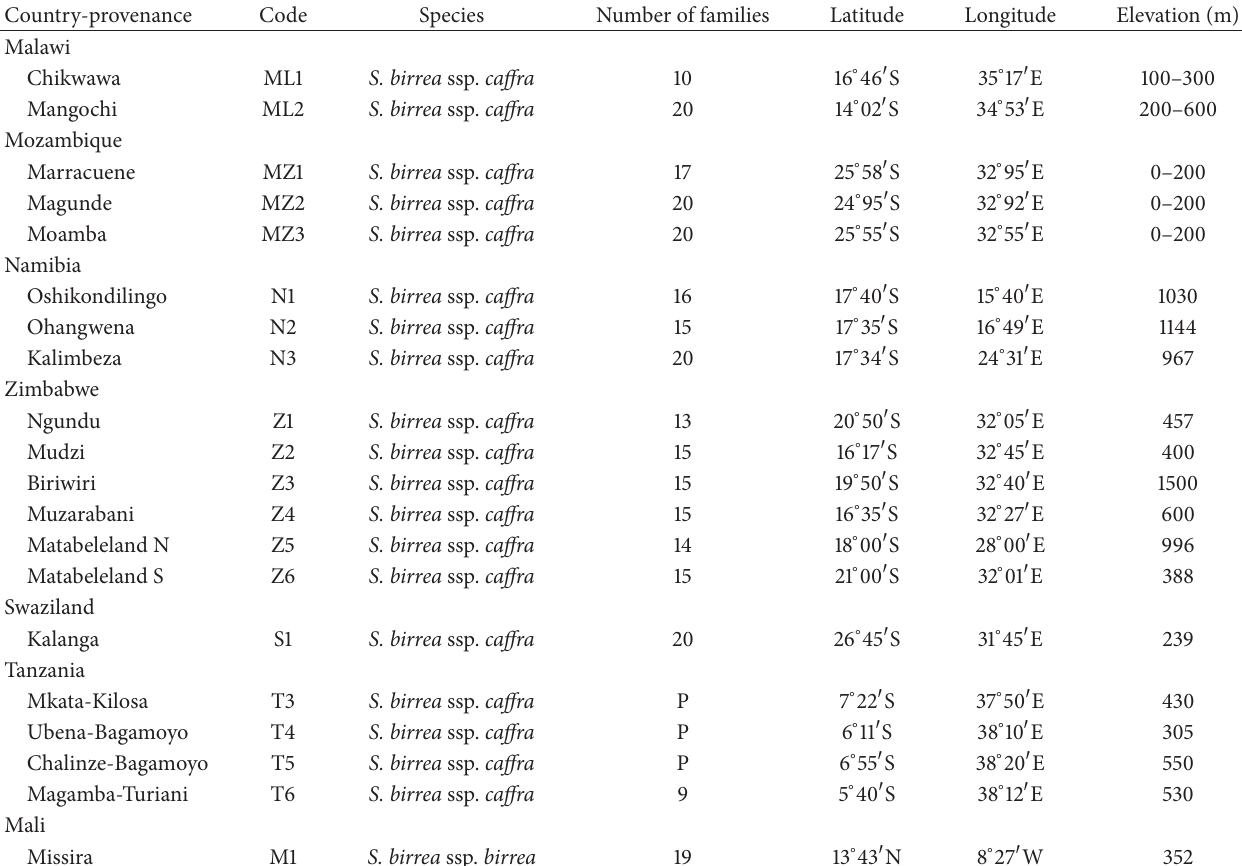
Table 1: Site characteristics of the original place of the fruiting provenances.